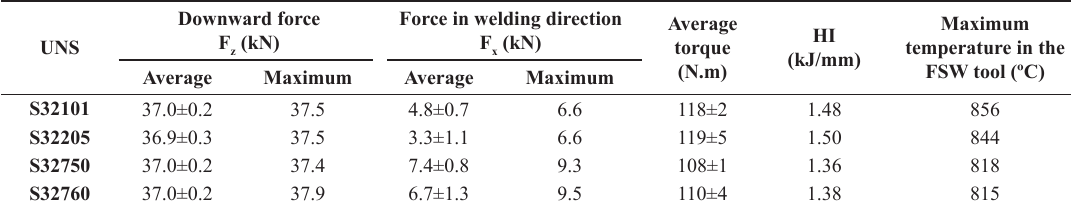
Table 4. Output variables from the FSW machine during welding of DSS and SDSS.